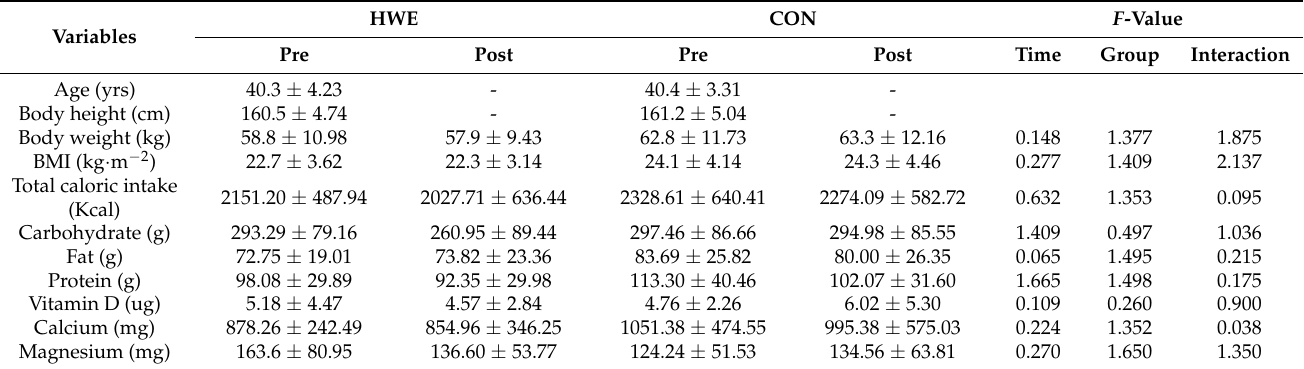
Table 1. Physical characteristics and nutritional intake of